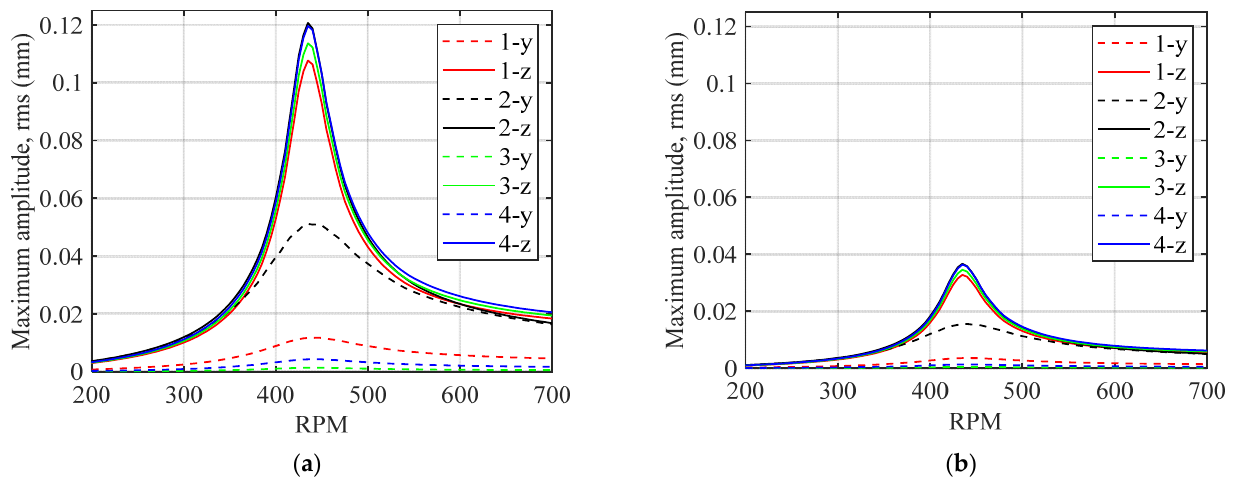
Figure 13. Unbalance response in simulation model ( a ) test-b, ( b )